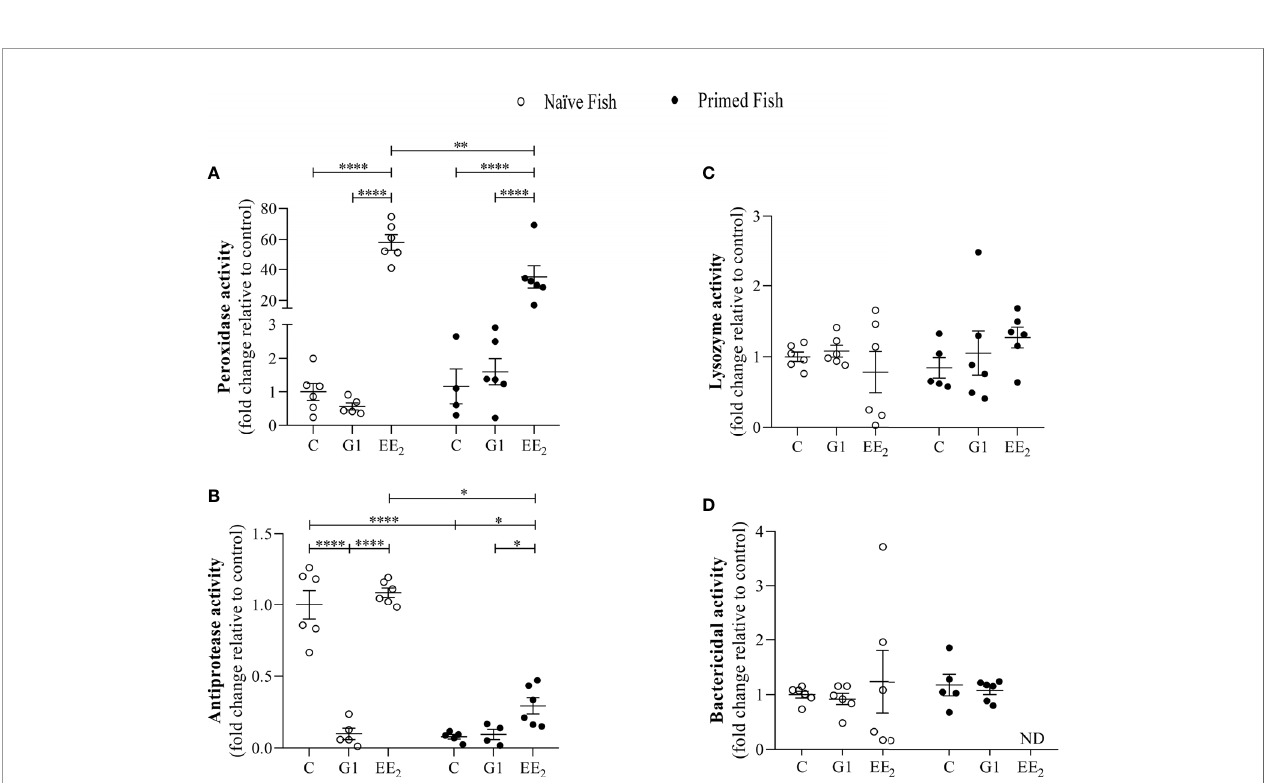
FIGURE 3 | 17 a -ethinylestradiol (EE2) exposure and further immune priming modulates the antimicrobial humoral activities in the serum of gilthead seabream. The fi sh had been orally treated with G1 or EE2 (5 m g/g food) for 43 days and either immune primed with KLH or not (naive) on the sampling day. (A) Peroxidase, (B) Lysozyme, (C) Antiprotease (D) Bactericidal activity. Data represents means ± standard error (n = 6). Asterisks denote statistically signi fi cant differences between the groups. *(p<0.05) **(p<0.01) ****(p<0.001).